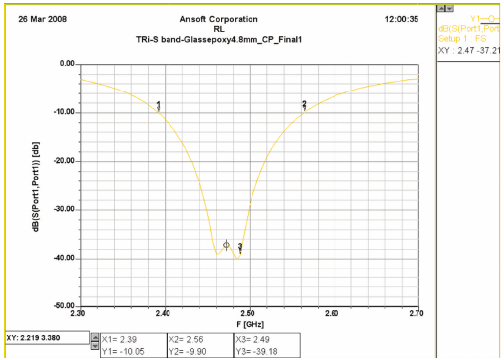
Figure 8: Simulated return